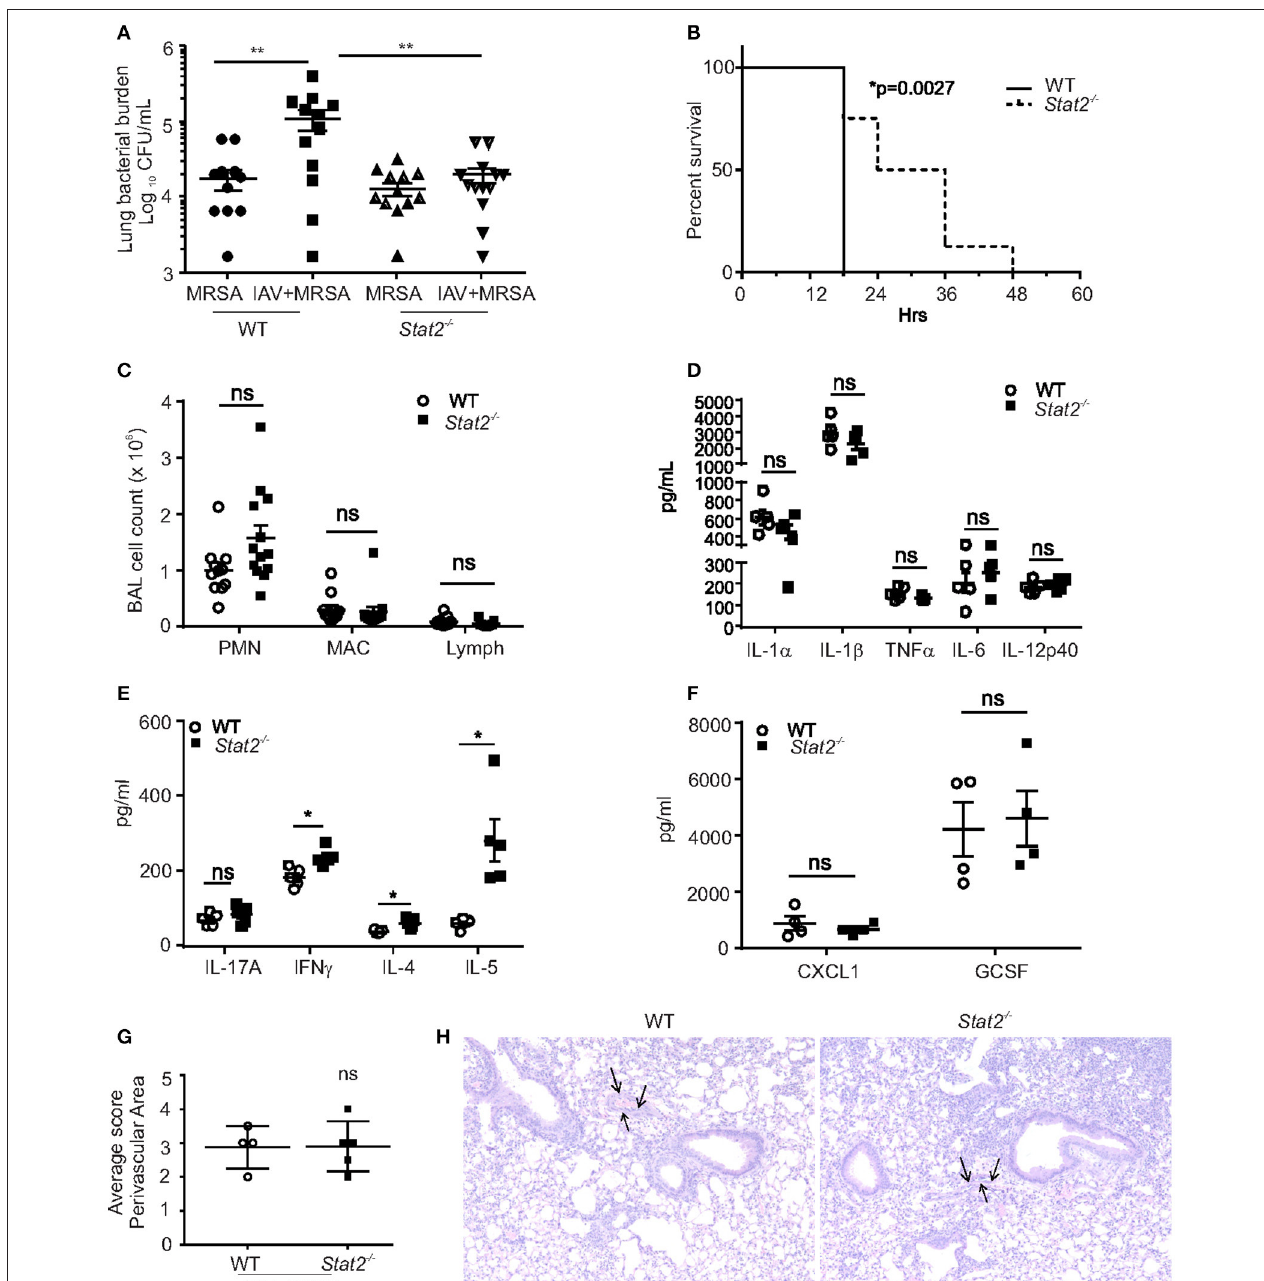
FIGURE 2 | Stat2 − / − are rescued from impaired bacterial clearance from the lung following influenza infection. (A) WT or Stat2 − / − mice were infected with 100 PFU of influenza for 6 days then challenged with 5 × 10 7 cfu of MRSA for one additional day. Right upper lung lobes were homogenized in PBS and bacterial burden was determined. N = 12–13 per group. (B) Adult female mice were infected with 66 PFU influenza A PR/8/H1N1 followed by challenge with 2 × 10 8 CFU MRSA and the survival was determined, N = 7–8 per group. (C) BAL samples collected from co-infected B6 and Stat2 − / − mice, cytospin the cells and differential counts were made, N = 11–13 per group. Right Upper lung lobes were homogenized in PBS, and (D) IL-1 α , IL-1 β , TNF α , IL-6, IL-12p40, (E) IL-17A, IFN γ , IL-4, IL-5 (F) CXCL1, and GCSF levels were measured by luminex assay, N = 4 per group. Representative data shown from three or more experiments. Lungs were fixed in 10% formalin, embedded in paraffin, (G) perivascular areas (arrows) were scored in formalin fixed lungs by staining with H&E (H) representative figures are shown, N = 4 per group. Original magnification for H&E sections × 100. Data are represented as mean ± SEM. Data analyzed using 2-tailed Student’s t -test or One way ANOVA followed by Bonferroni test for multiple comparisons, * p < 0.05, ** p < 0.01, ns, not significant.